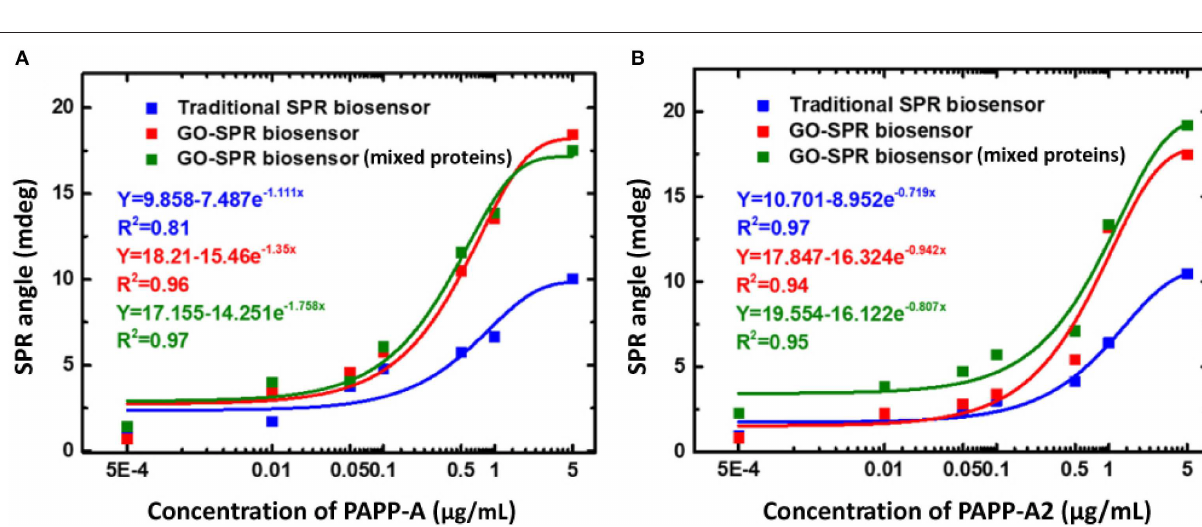
research results on graphene-based SPR biosensors and the results